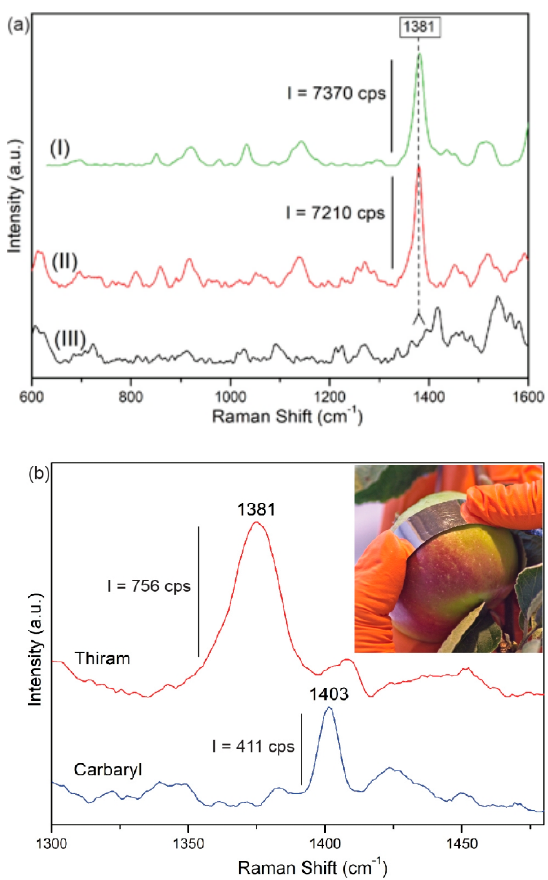
Figure 8. ( a ) SERS spectra on PET/ITO/Ag platform recorded for Thiram pesticide solution (I), Thiram in apple juice (II), and apple juice (III), and ( b ) the detected traces of both Thiram and Carbaryl taken from an apple’s skin. The inset presents photo of pesticide collection from an apple’s skin. SERS spectra were recorded using a 785 nm laser excitation with the laser power below 5 mW with three accumulations for four seconds.